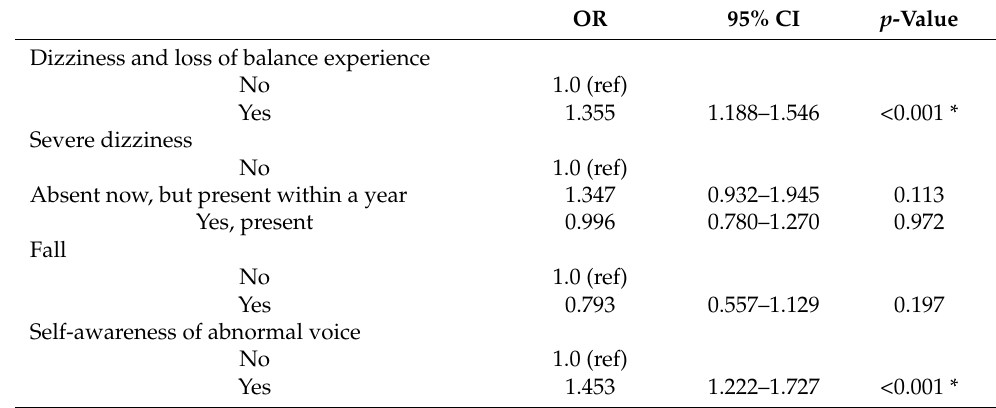
Table 2. Factors that affect the occurrence of dry eye after adjusting for age (60 years) and